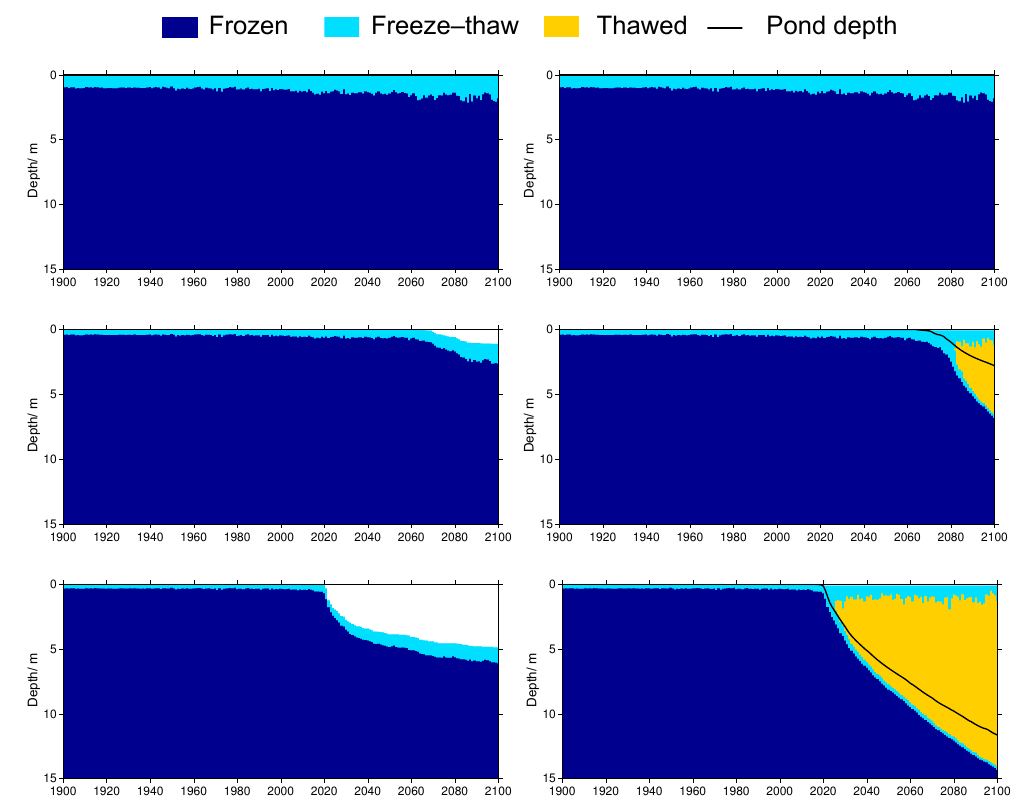
Figure 7. Annual freeze–thaw state for three different cryostratigraphies (top to bottom: Arga, Samoylov, ice complex) and the drainage scenarios subsidence (left) and thermokarst (right), as simulated by CryoGrid 3 Xice forced by CRU-NCEP/CCSM4 and the moderate future warming scenario RCP